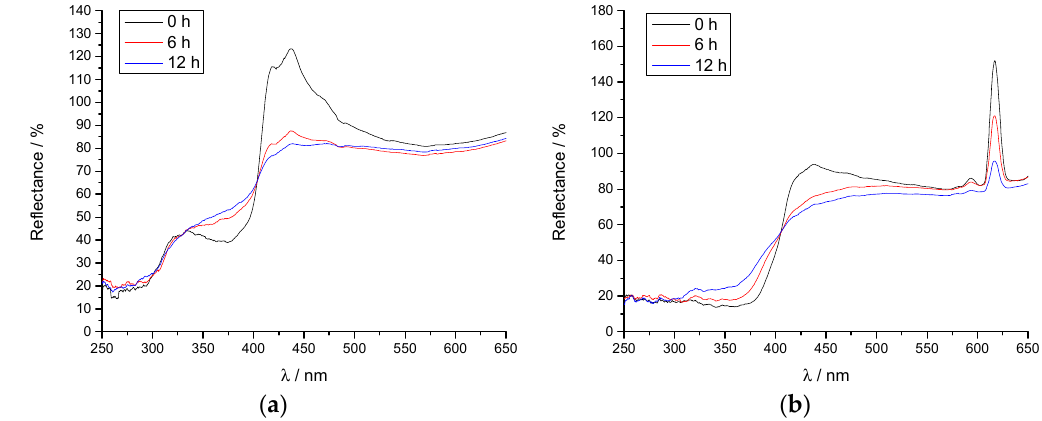
Figure 4. Spectral reflectance of unaged and aged samples: ( a ) transparent base; ( b ) TB + FP (without the nanoparticles).